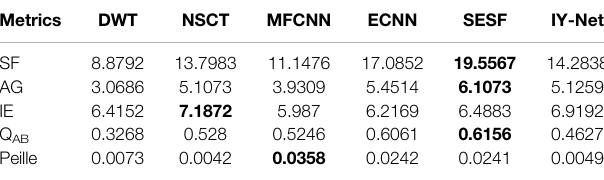
Bold indicates best values.